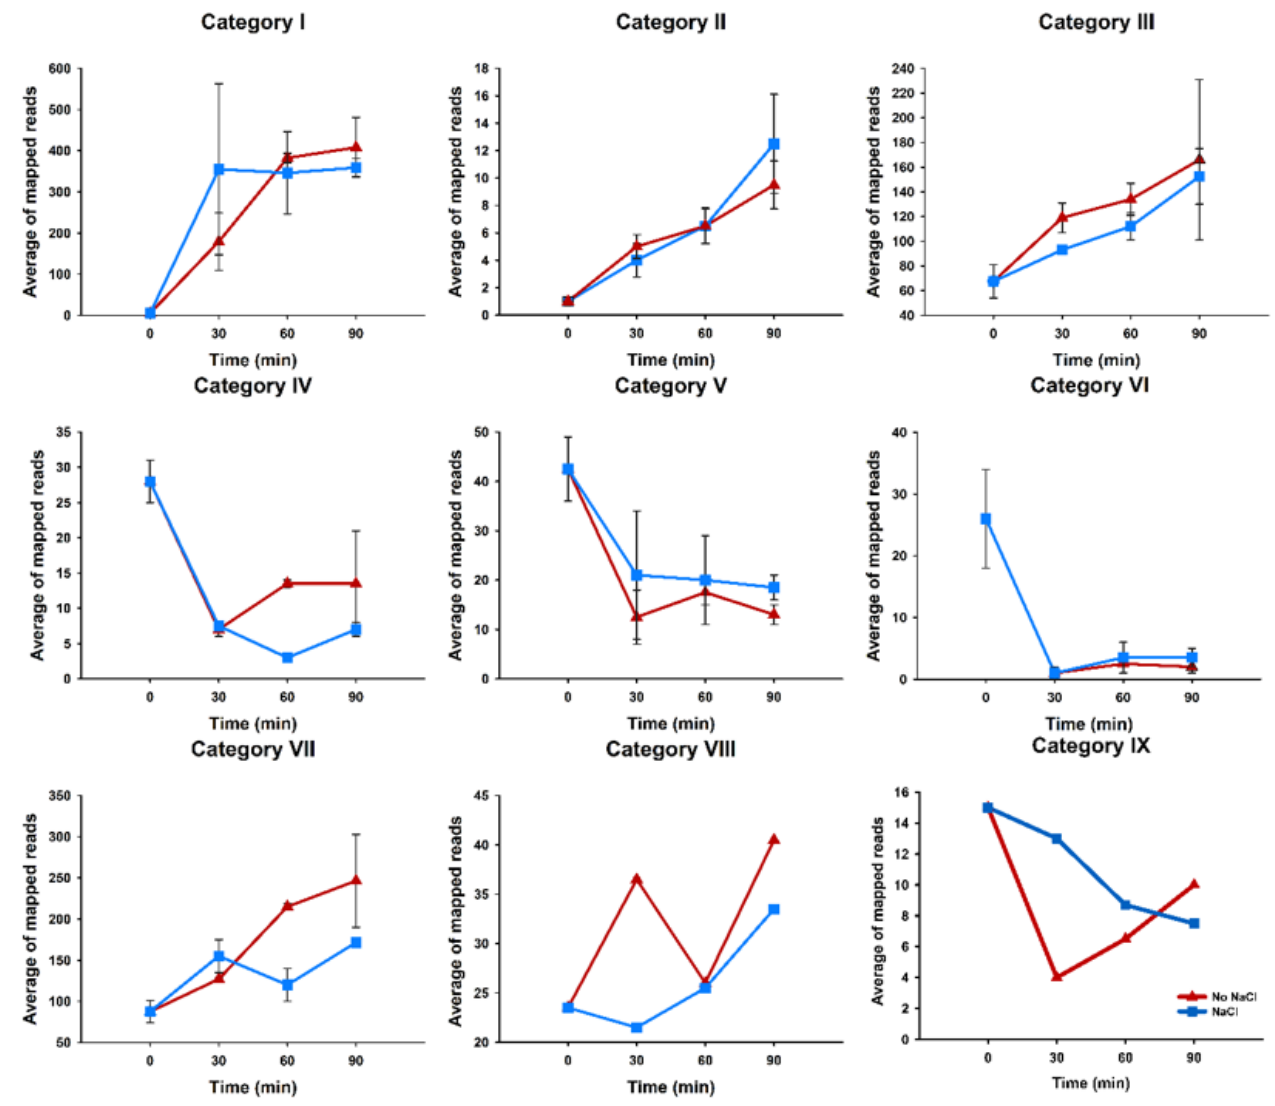
Figure 3. Overview of subpopulations of tRNA Cys molecules in B. subtilis dormant spores and during the outgrowth phase in the presence and absence of 1.2 M NaCl. Average of reads mapped for each category were plotted. Error lines represent standard errors of